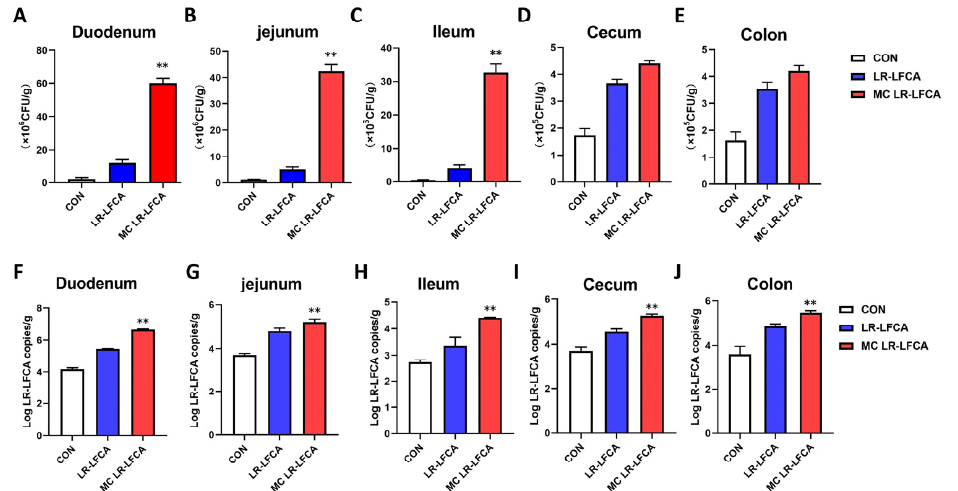
Figure 5. Microencapsulated LR-LFCA was assessed for its ability to colonize neonatal piglet intestinal mucosa. ( A – E ) The number of colonizing bacteria in the duodenum ( A ), jejunum ( B ), ileum ( C ), cecum ( D ), and colon ( E ) was verified using bacterial colony counting. ( F – J ) Quantification of total bacterial L. reuteri gene copy numbers in the duodenum ( F ), jejunum ( G ), ileum ( H ), cecum ( I ), and colon ( J ) were assessed using qPCR. Data are presented as the mean ± SD, ** p < 0.01 vs. LR-LFCA.